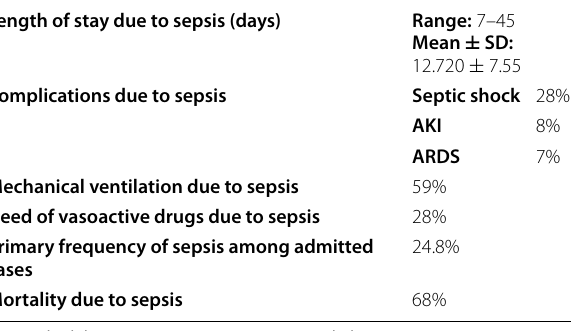
SD standard deviation, % Percentage, AKI acute kidney injury, ARDS acute respiratory distress syndrome